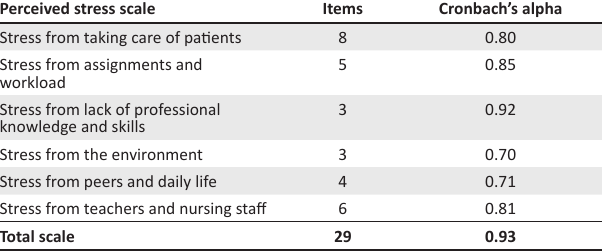
TABLE 3: Internal consistency of the perceived stress scale †